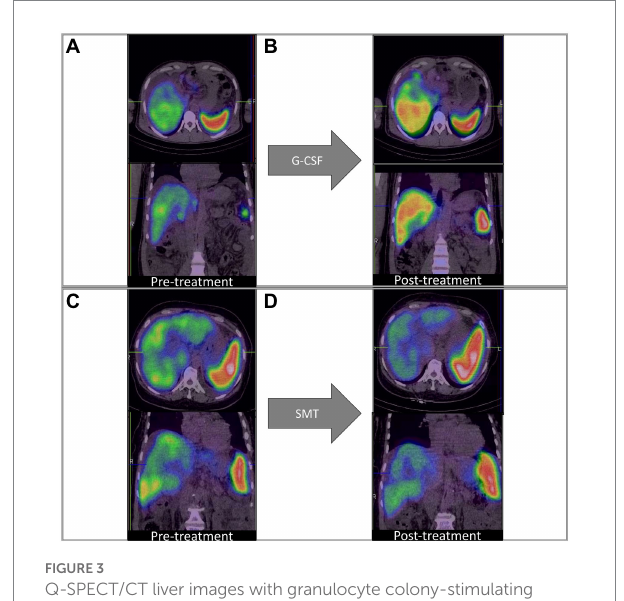
FIGURE 3 Q-SPECT/CT liver images with granulocyte colony-stimulating factor; G-CSF treatment [Panels (A,B) ] and standard medical treatment (SMT) [Panels (C,D) ] in representative DC patients. (A,B) Rise in %QLU (30 to 45%) and LV (964 to 1,016 cc) after G-CSF treatment (C,D) Fall in %QLU (41 to 36%) and LV (1,264 to 965 cc) after SMT